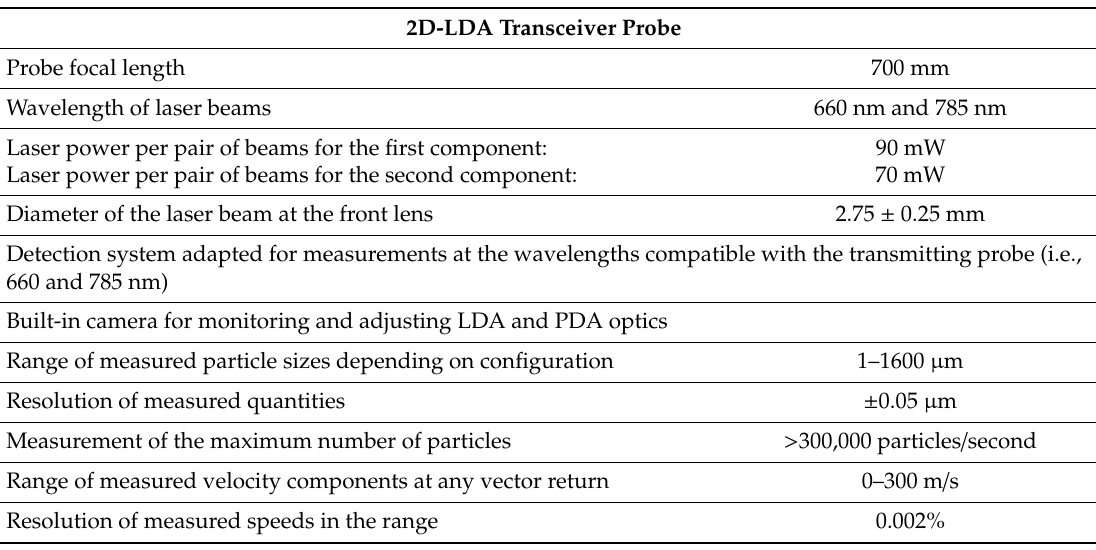
Table 1. Main 2D-LDA / PDA analyzer